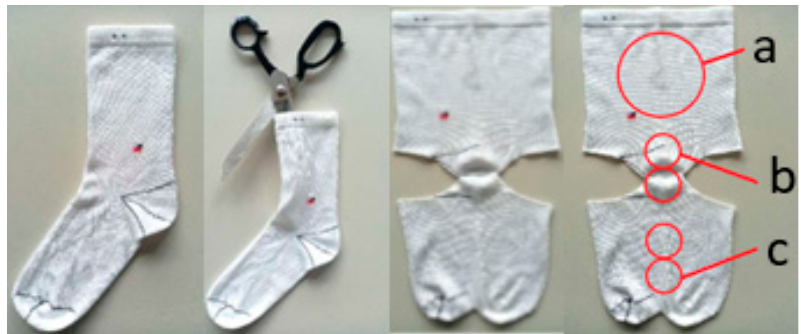
Figure 5. Cutting the socks and the sampling of the test specimens: ( a ) for testing the propensity to surface pilling, mass per unit area and water vapor absorption; ( b , c ) for testing the abrasion re- sistance.